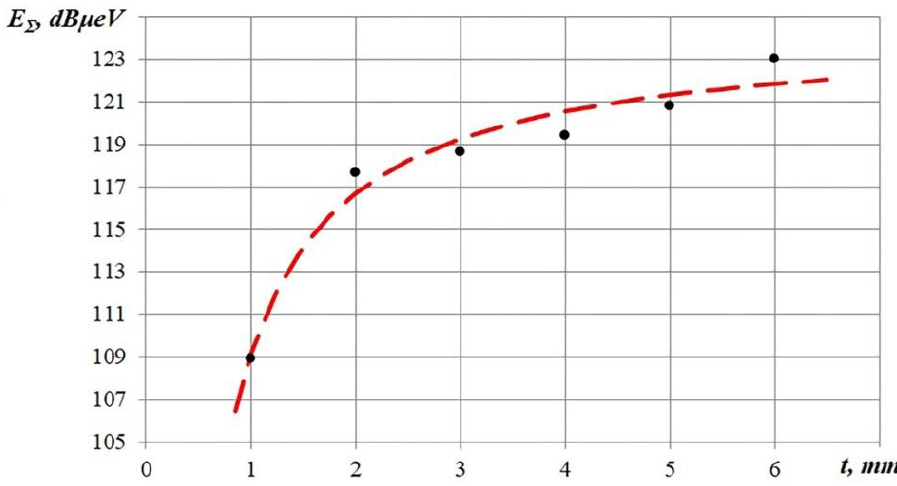
Figure 10. Influence of the specimens ’ thickness t on the cumulative energy of AE signals E Σ .